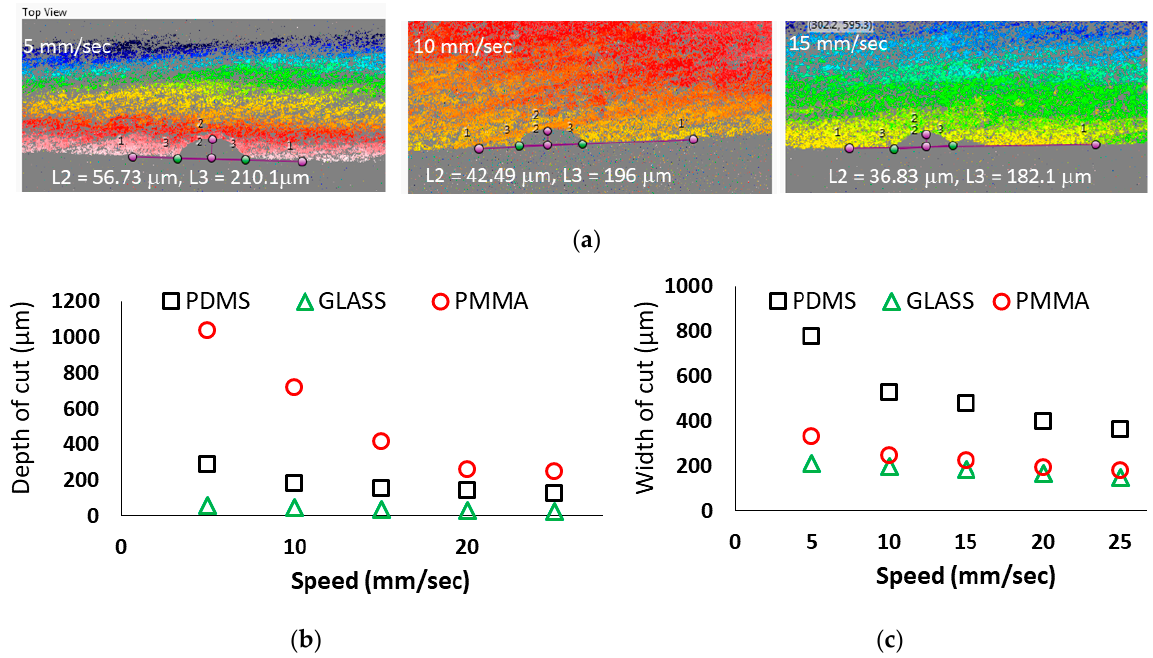
Figure 5. ( a ) 3D profilometer images and measurement of glass microchannel characteristics at various scanning speeds. The laser machined microchannel’s ( b ) depth and ( c ) width are shown as function of laser scanning speed. The specimen was placed at the focal distance of the CO 2 laser engraving machine. The laser system was set at 10% i.e., 4.5 W, single pass and scanning speed at 10 mm/s.